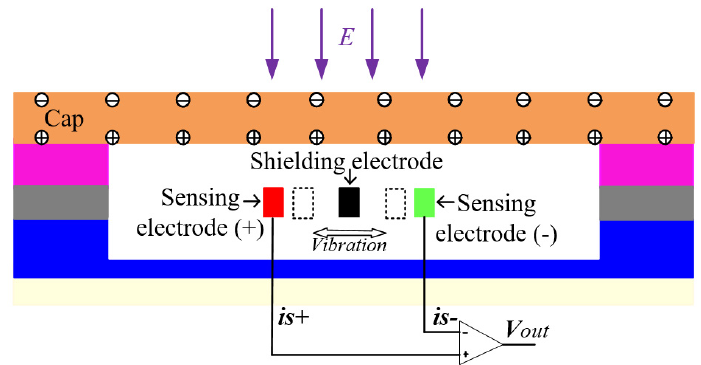
Figure 2. Schematic diagram of the sensor’s working principle.